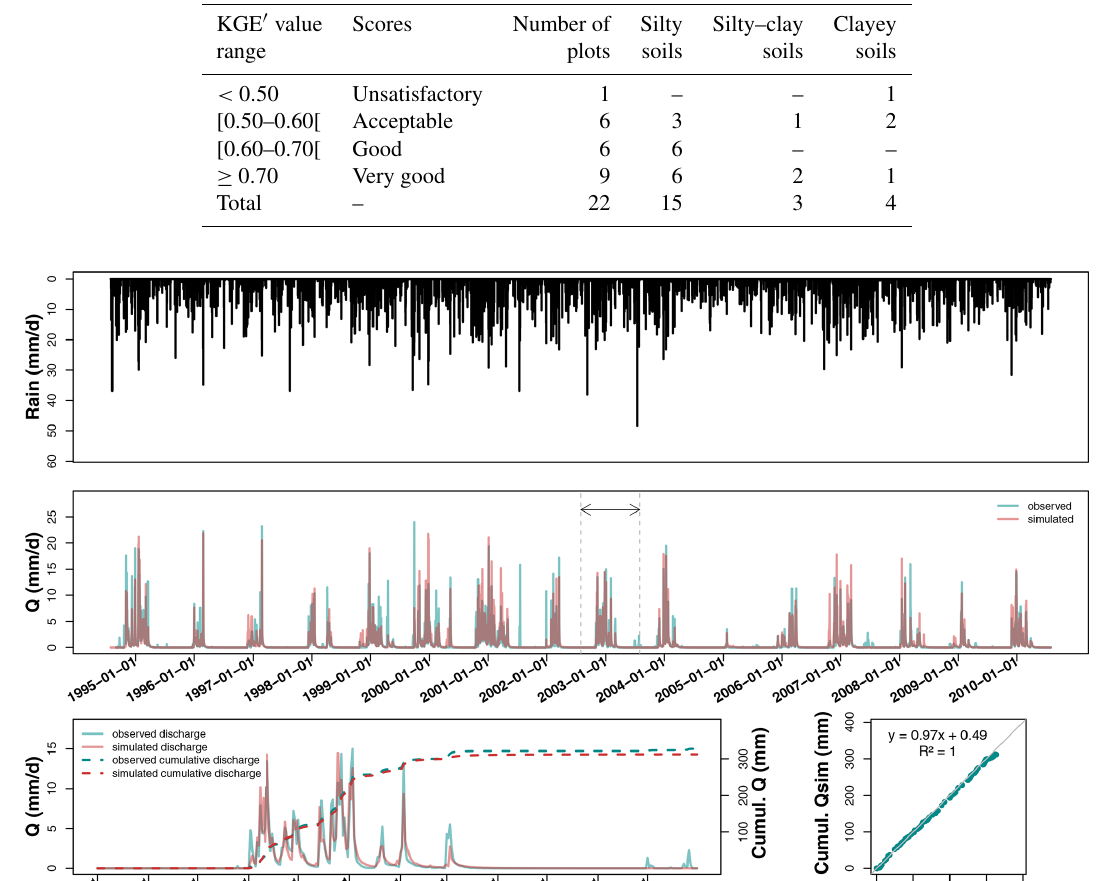
Table 2. KGE (cid:48) calibration scores.